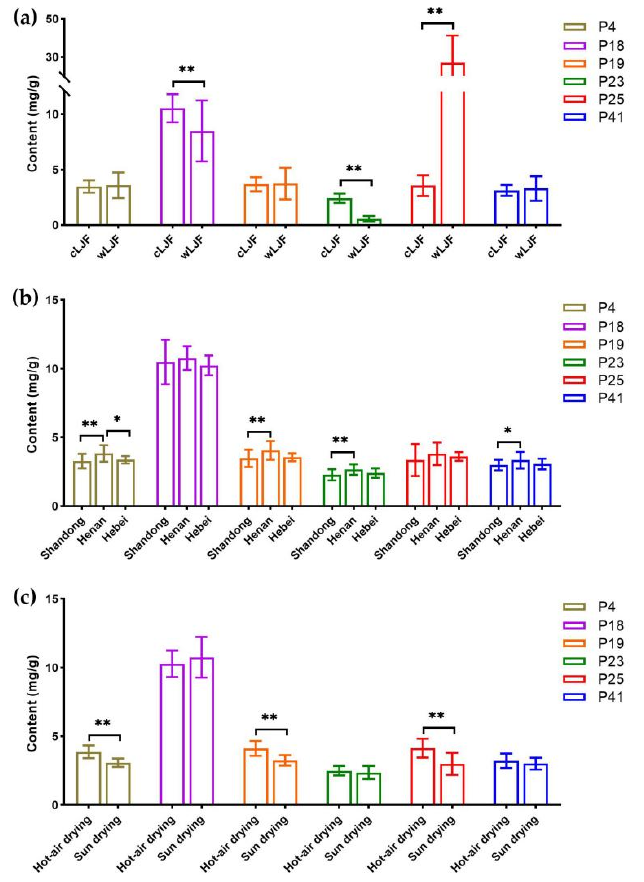
Figure 6. Comparison of the content of 6 bioactive compounds in LJF samples. ( a ) Comparison of the content between cLJF and wLJF. ( b ) Comparison of the content among cLJF samples from Shandong, Henan and Hebei. ( c ) Comparison of the content between cLJF samples processed by hot-air drying and sun drying. * p < 0.05, ** p < 0.01. P4, neochlorogenic acid; P18, chlorogenic acid; P19, cryptochlorogenic acid; P23, sweroside; P25, secoxyloganin; P41, 4,5-Di- O -caffeoylquinic acid).